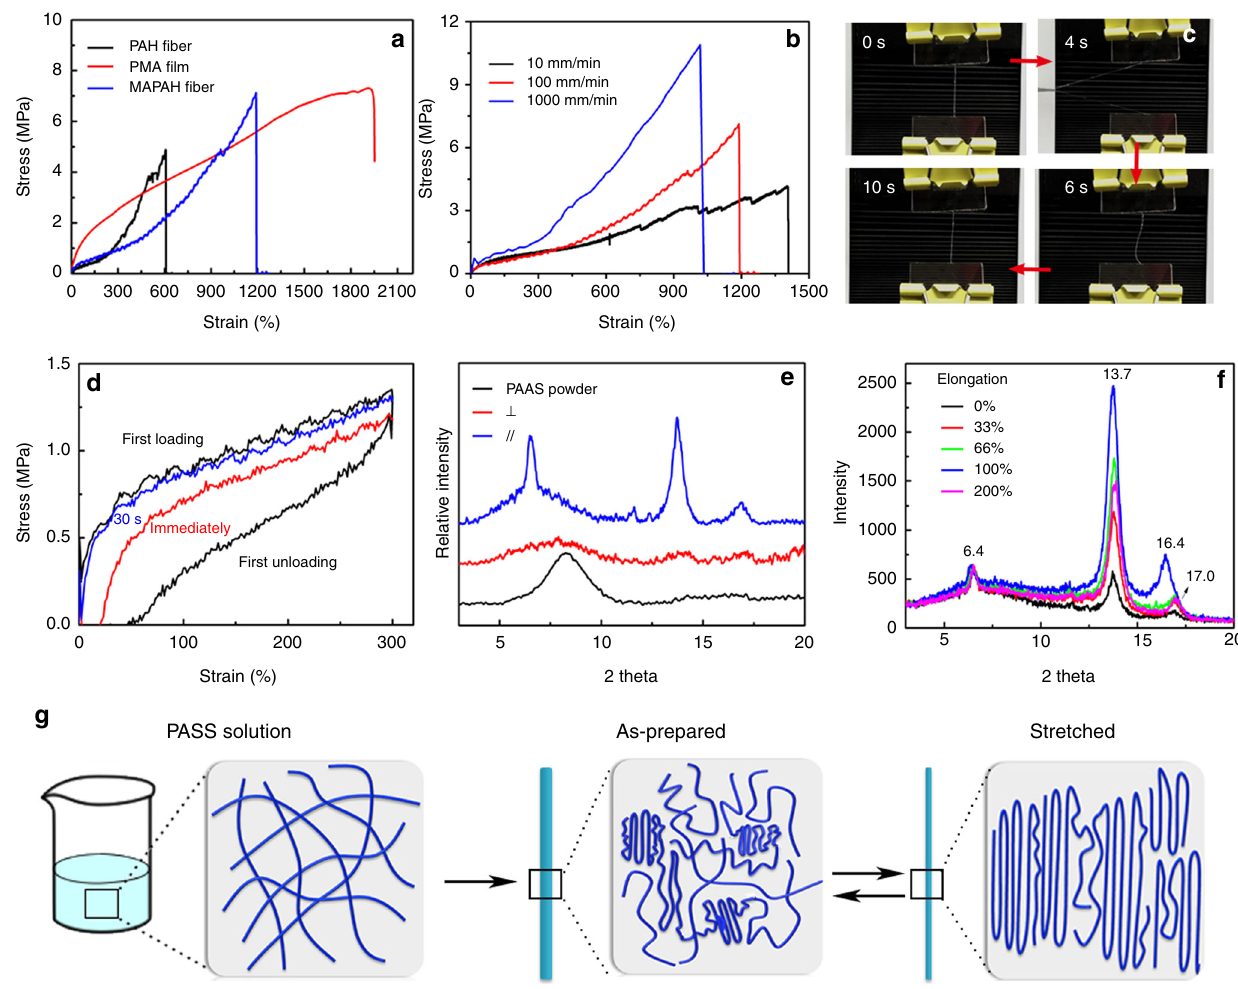
Fig. 3 Mechanical and structural characterization of hydrogel fi bers. a Stress – strain pro fi les of a PMA fi lm, PAH, and MAPAH fi bers at 100 mm min − 1 stretching rate. b Stress – strain pro fi les of a MAPAH fi ber under different stretching rates. c Photograph of a MAPAH fi ber showing the hysteresis effect during its recovery process. d Stress – strain pro fi les of a MAPAH fi ber subjected to a loading – unloading cycle at 300% strain (black curve). Immediately after the 1st cycle, the fi ber was stretched to 300% strain (red curve). The same fi ber was unloaded and stretched to 300% strain after a 30 s recovery at ambient condition (blue curve). e XRD spectra of PAAS powder, and MAPAH fi bers placed parallel or perpendicular to the X-ray incidence direction. f XRD spectra of MAPAH fi bers under different stretching strains. g Proposed molecular organization and orientation of PAAS chains at different conditions. PAAS is solvated and randomly oriented in solution. Coexistence of crystalline and amorphous domains in as-prepared hydrogel fi bers. Mechanical stress enables PAAS chains a higher degree of crystallization and orientation along the